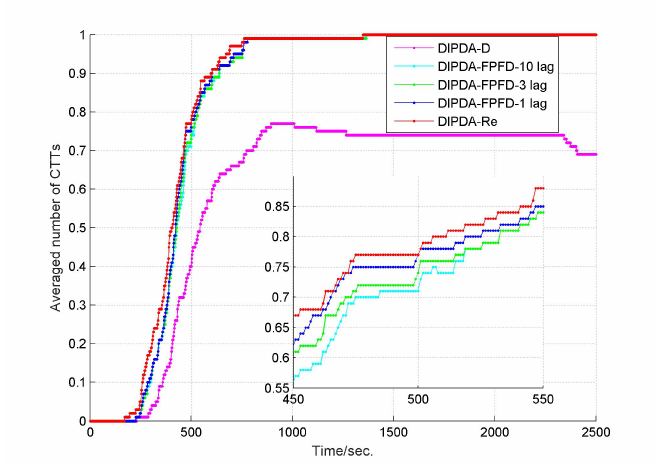
Figure 12. RMSE of estimated target velocity of DIPDA-D, DIPDA-Re, DIPDA-FPFD with different lags (case 2).